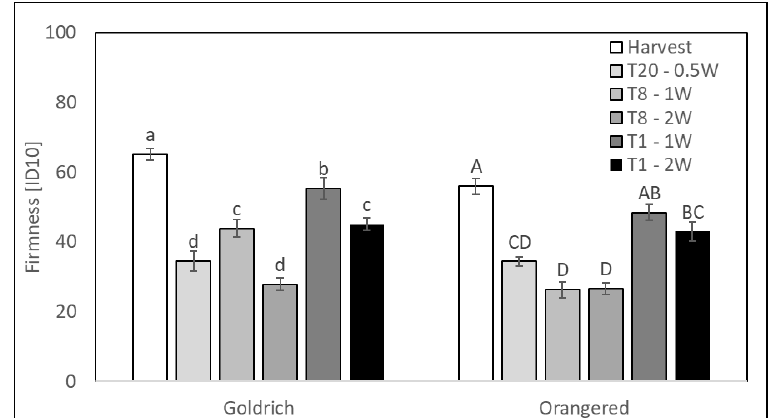
Figure 4. Influence of storage temperature on firmness measured by AGROSTA ® 100 device on ‘Goldrich’ and ‘Orangered ® ’ apricots stored at 1 °C (T1), 8 °C (T8) and 20 °C (T20) during 0.5, 1 or 2 weeks (W). Means with the same letters are not significantly different at p ≤ 0.05 in Tukey’s multiple range test.